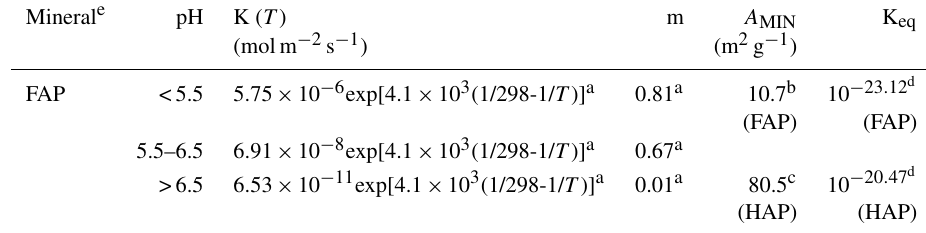
Table 2. Fluorapatite (FAP) acid dissolution constants used for this